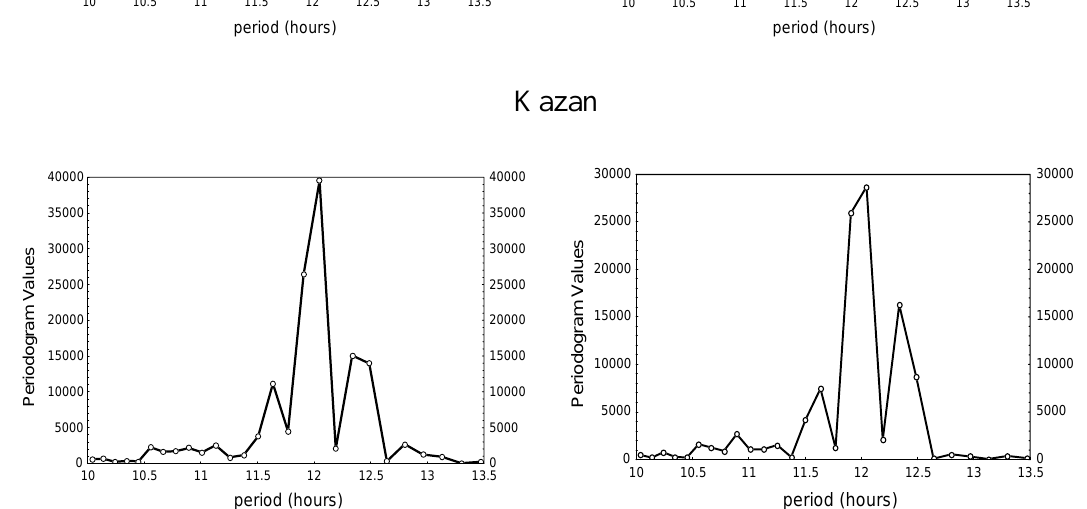
riods centred at Days 10 and 40. The vertical lengths of the oscillation and the modulation are not in agreement for the first case. The vertical wavelength of the modulation is about 45 km. It proves too short to obtain the true values of phases at sites without height finding. The crucial point is a chang-